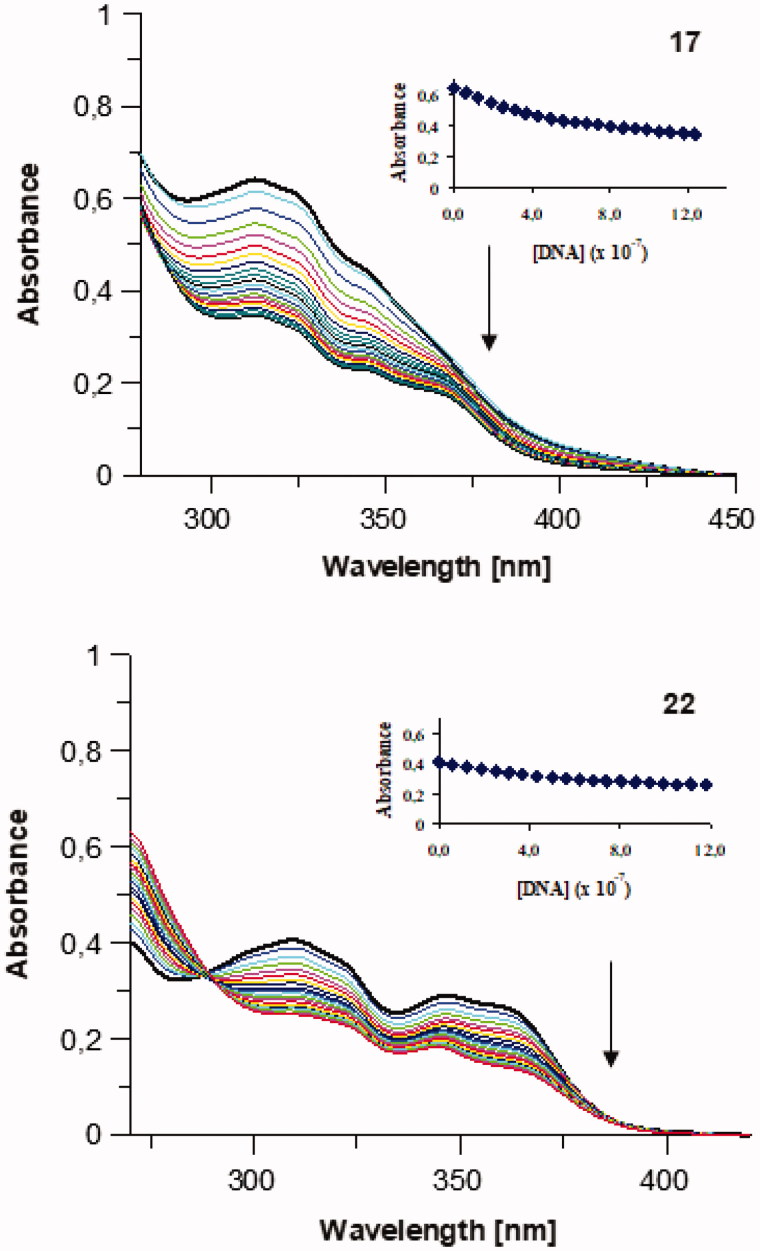
UV–vis absorption titration spectra of studied 7-MEOTA-THA thiourea 17 (49 µM) and urea 22 (49 µM) in 10 mM Tris–HCl buffer (pH 7.4; RT) with increasing concentration of ctDNA (0–1.24 µM). Arrows indicate the changes after addition of increasing concentration of ctDNA. Inserted graphs represent the non-linear fitting of absorption titration, the plot of [DNA] versus appropriate absorbance.